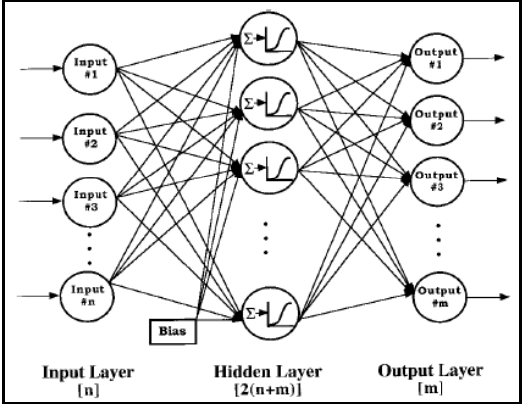
Fig. 2. Architeture for ANN